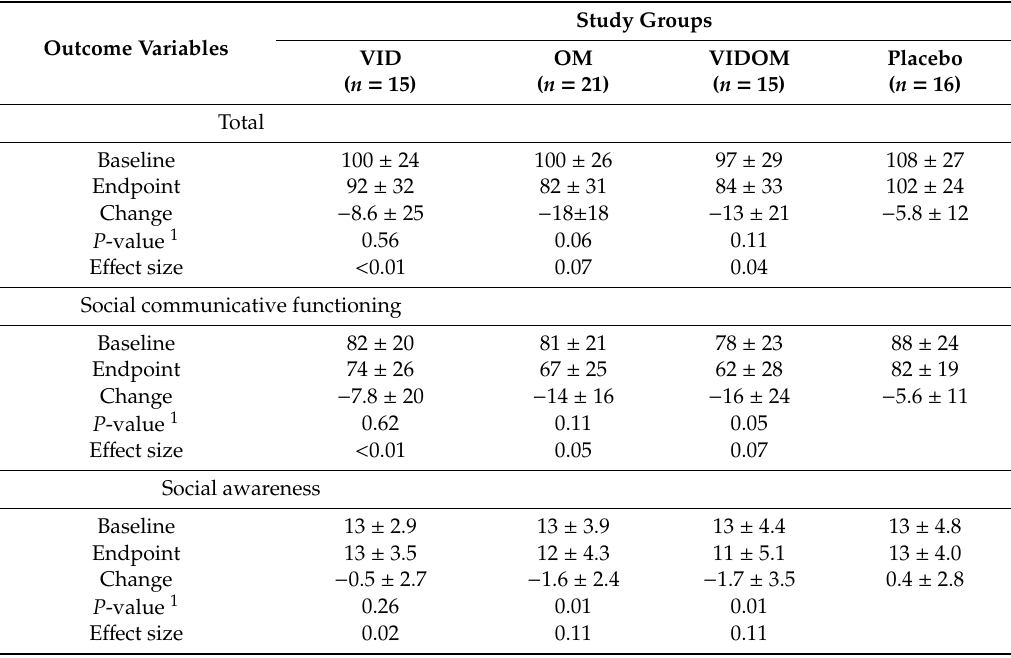
Table 3. Core symptoms of ASD assessed using the Social Responsiveness Scale (SRS) among children whose IL-1 β was available at baseline and who completed the study across treatment groups ( n = 67).